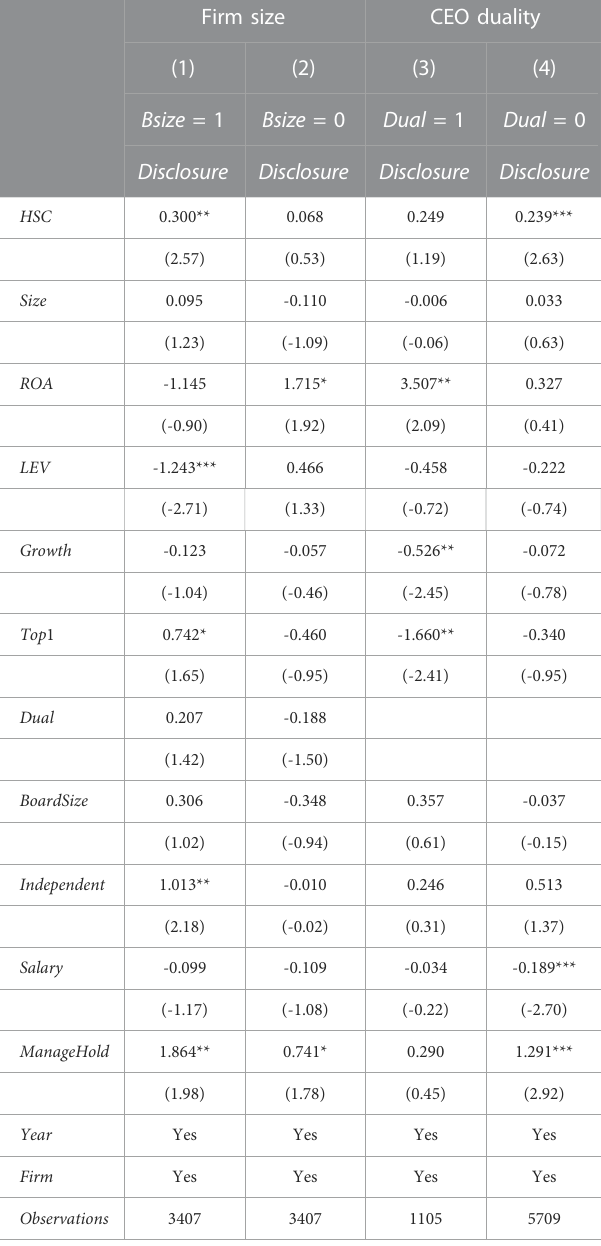
TABLE 6 Capital Market Liberalization and ESG Disclose: by Corporate Characteristics:Thistableshowshowtheeffectofcapital marketliberalization varies by corporate characters. We split fi rms into two groups based on fi rm size andCEOduality, respectively. Bsize isadummyvariable that takes1when the logarithm of a fi rm ’ s asset value is greater than the median of the sample, and 0 otherwise. Dual takes 1 when a Chief Executive Of fi cer (CEO), besides running the corporation at the highest level, also holds the position of the ChairmanoftheBoard,and0otherwise.Thedependentvariable Disclosure isa score for the fi rm-level ESG disclosure. The independent variable HSC is a dummy variable thattakesthevalue oneifthe fi rmentersthelistofShanghai- Hong Kong or Shenzhen-Hong Kong Stock Connect schemes, and zero otherwise.Othercontrolvariablesinclude fi rmsize( Size ),returnontotalassets ( ROA ), fi nancialleverage ( LEV ),growthrate( Growth ),ownershipconcentration ( Top 1), integration of two positions ( Dual ), board size ( BoardSize ), the ratio of independent directors ( Independent ), top three executives ’ compensation ( Salary ), and management shareholding ratio ( ManageHold ). Refer to Table 1 for detailed variable de fi nitions. t -statistics are reported in parentheses.***, ** and * denote signi fi cance levels at 1%, 5% and 10%,